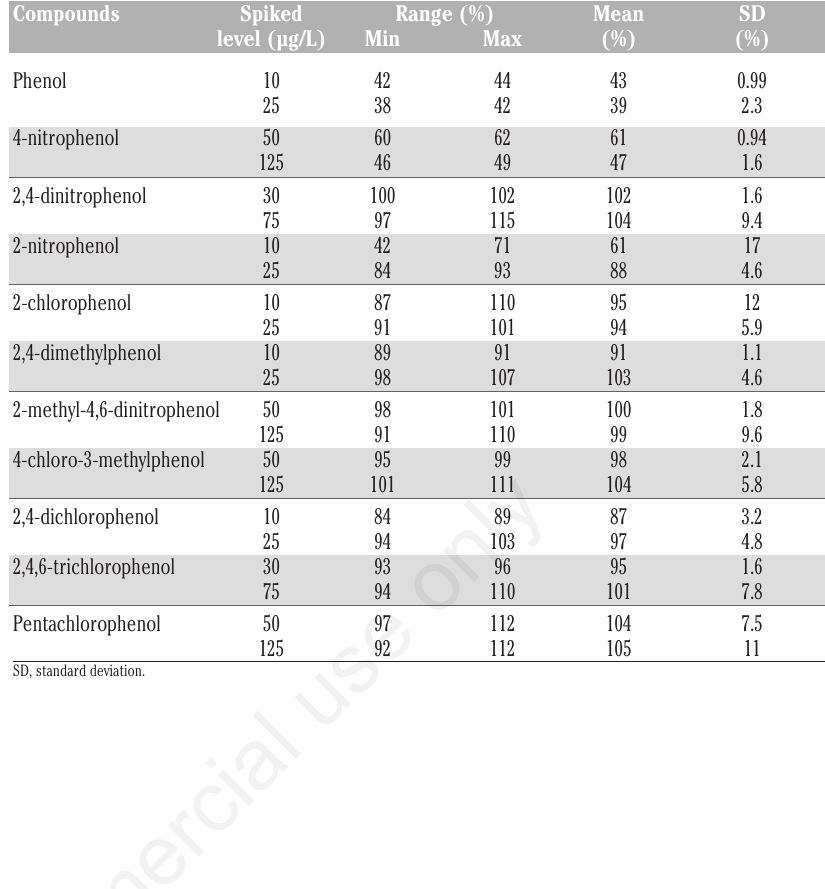
Table 4. Determination of the method accuracy as recovery (%) of phenolic compounds from distilled water spiked with different levels of standard concentration (n=3). Compounds